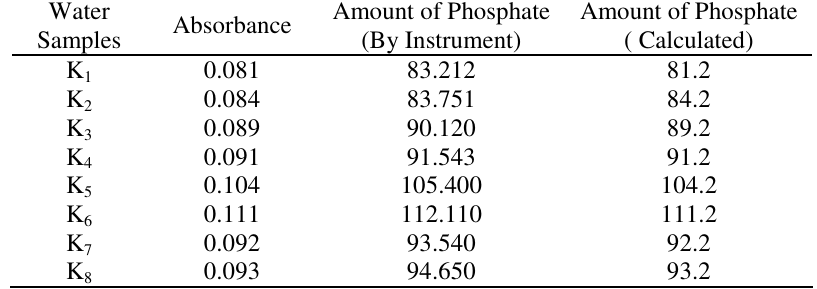
Table 4. Absorbance and concentration of phosphate (by Instrument and Calculation) of water samples of Kadva River.